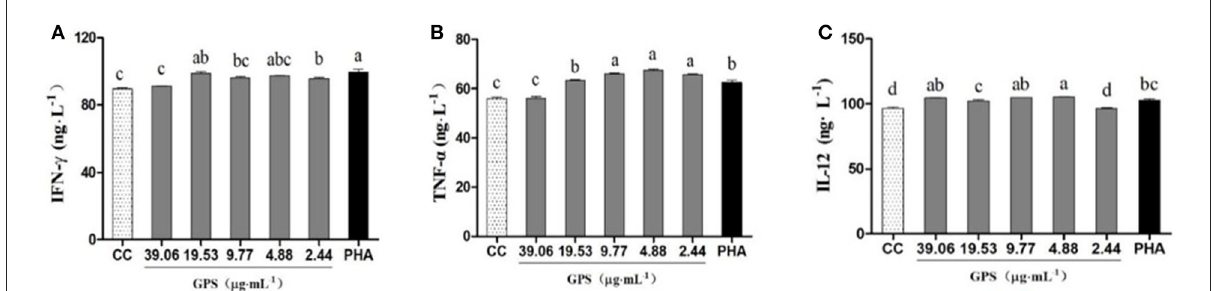
FIGURE3 Effects of GPS-1 on the secretion of cytokines by lymphocytes. (A) IFN- γ ; (B) TNF- α ; (C) IL-12. a − d Values in the same column with different superscript letters differ significantly at p < 0.05.